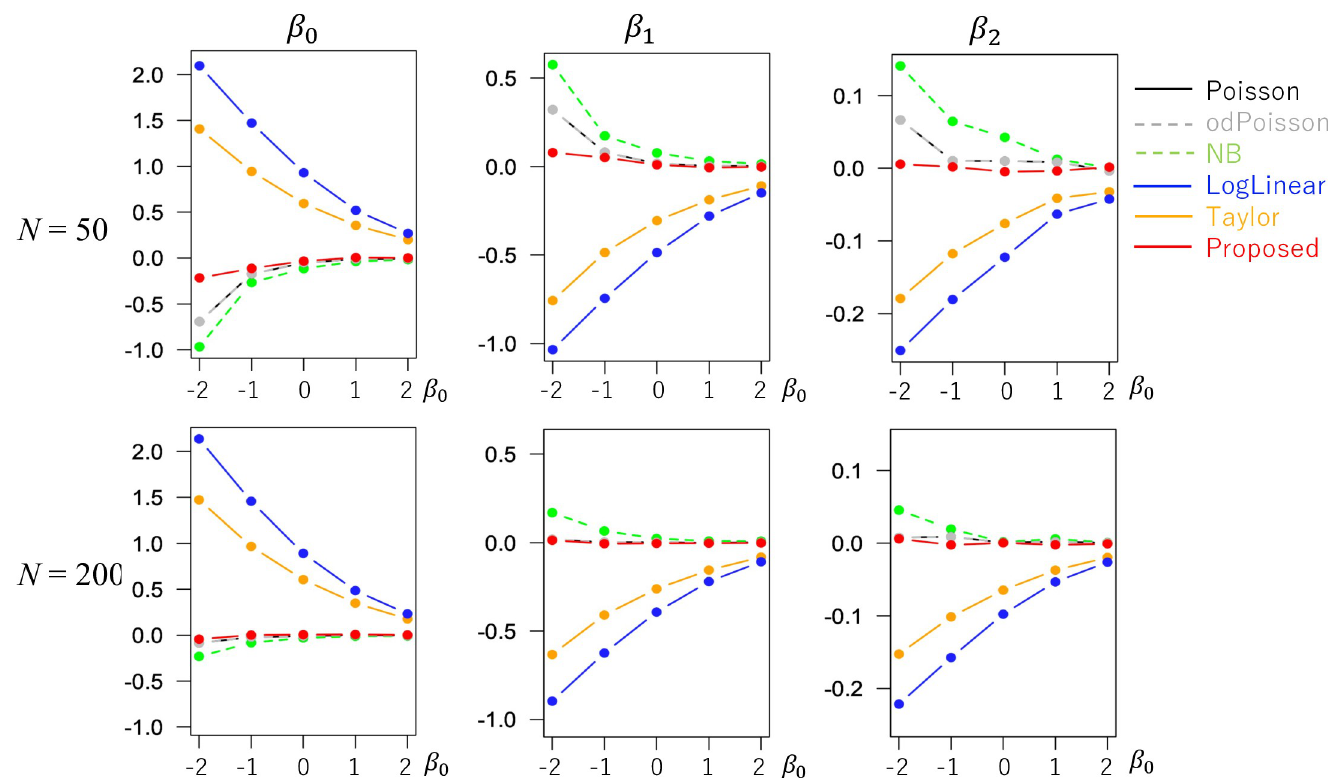
Fig 4. Bias of the regression coefficients in cases with overdispersion ( σ 2 = 5.0) (x − axis: β 0 , y-axis: Bias).